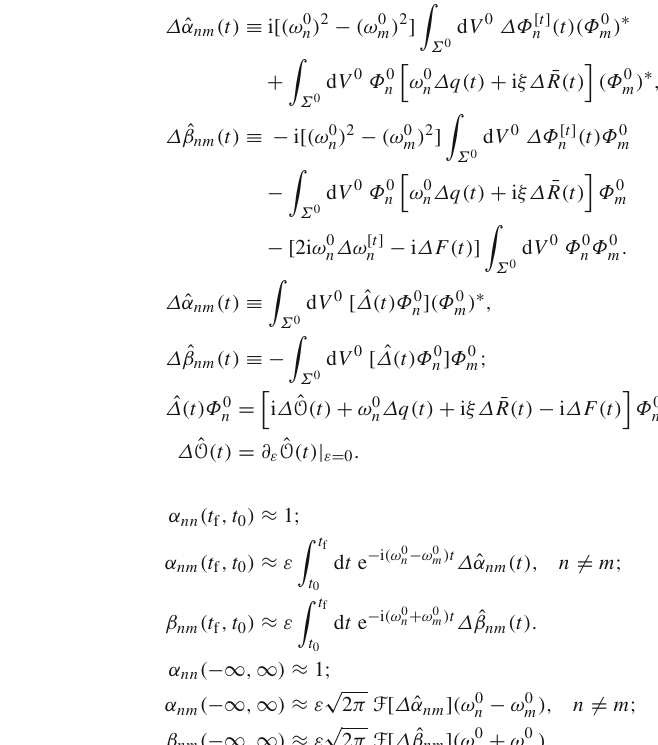
Table 2 Summary of formulae for the application of the method (part 2) Quantities Δ ˆ α and Δ ˆ β (Perturbative